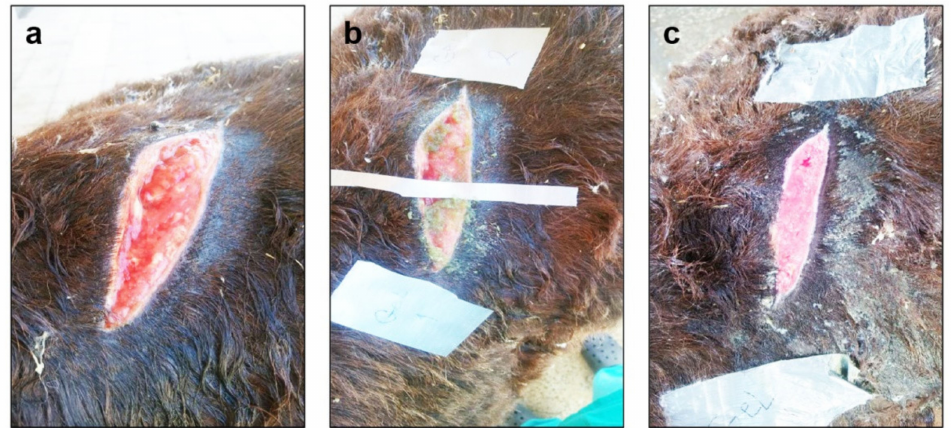
Figure 7. ( a ) Four-year-old male donkey with an old lacerated accidental wound on the back. ( b ) The wound was divided into two parts and treated with gel (1) S. arghel EtOAc gel and gel (2) S. arghel MeoH extract gel. ( c ) The same animal, after 9 days of treatment, showed decreased wound size and complete epithelization of the wound.